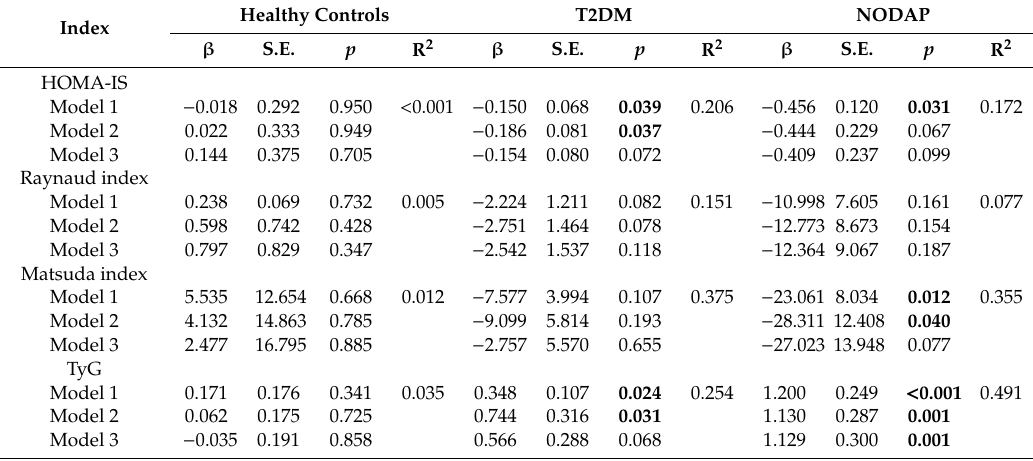
Associations between visceral fat volume and indices of insulin sensitivity in non-obese